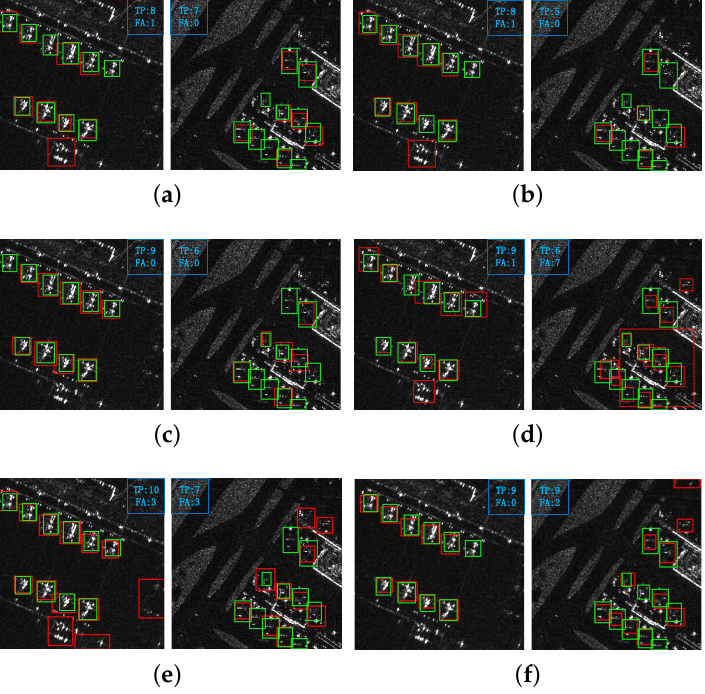
Figure 10. The detection results reported in Table 1. The red boxes represent the detection results and the green boxes represent the ground truth. We count the evaluation results in blue boxes. TP means accurately detected targets and FA means false alarms. ( a ) Faster R-CNN [16]. ( b ) Cascade R-CNN [17]. ( c ) SSD [15]. ( d ) RetinaNet [39]. ( e ) Yolov3 [14]. ( f )